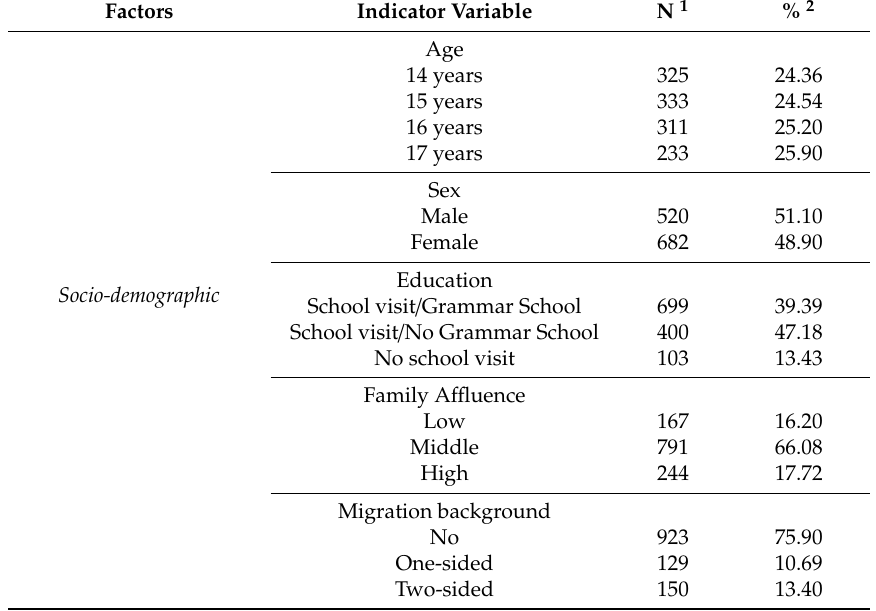
Table 2. Socio-demographic, social and personal factors among adolescents aged 14–17 ( n = 1202) of the GeKoJu 2019 study